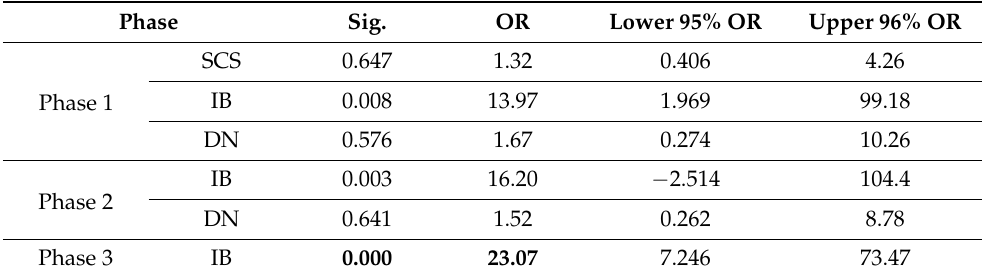
Table 4. Multivariate analysis of predictors of positive urine